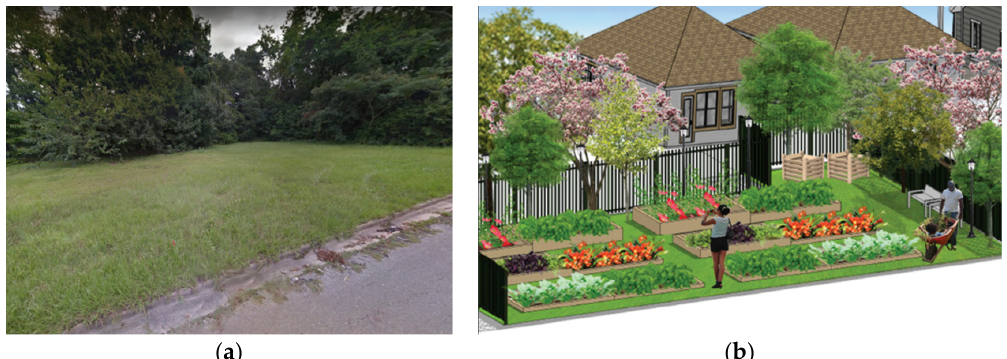
Figure 9. Eco district community garden: before (a); and after (b).